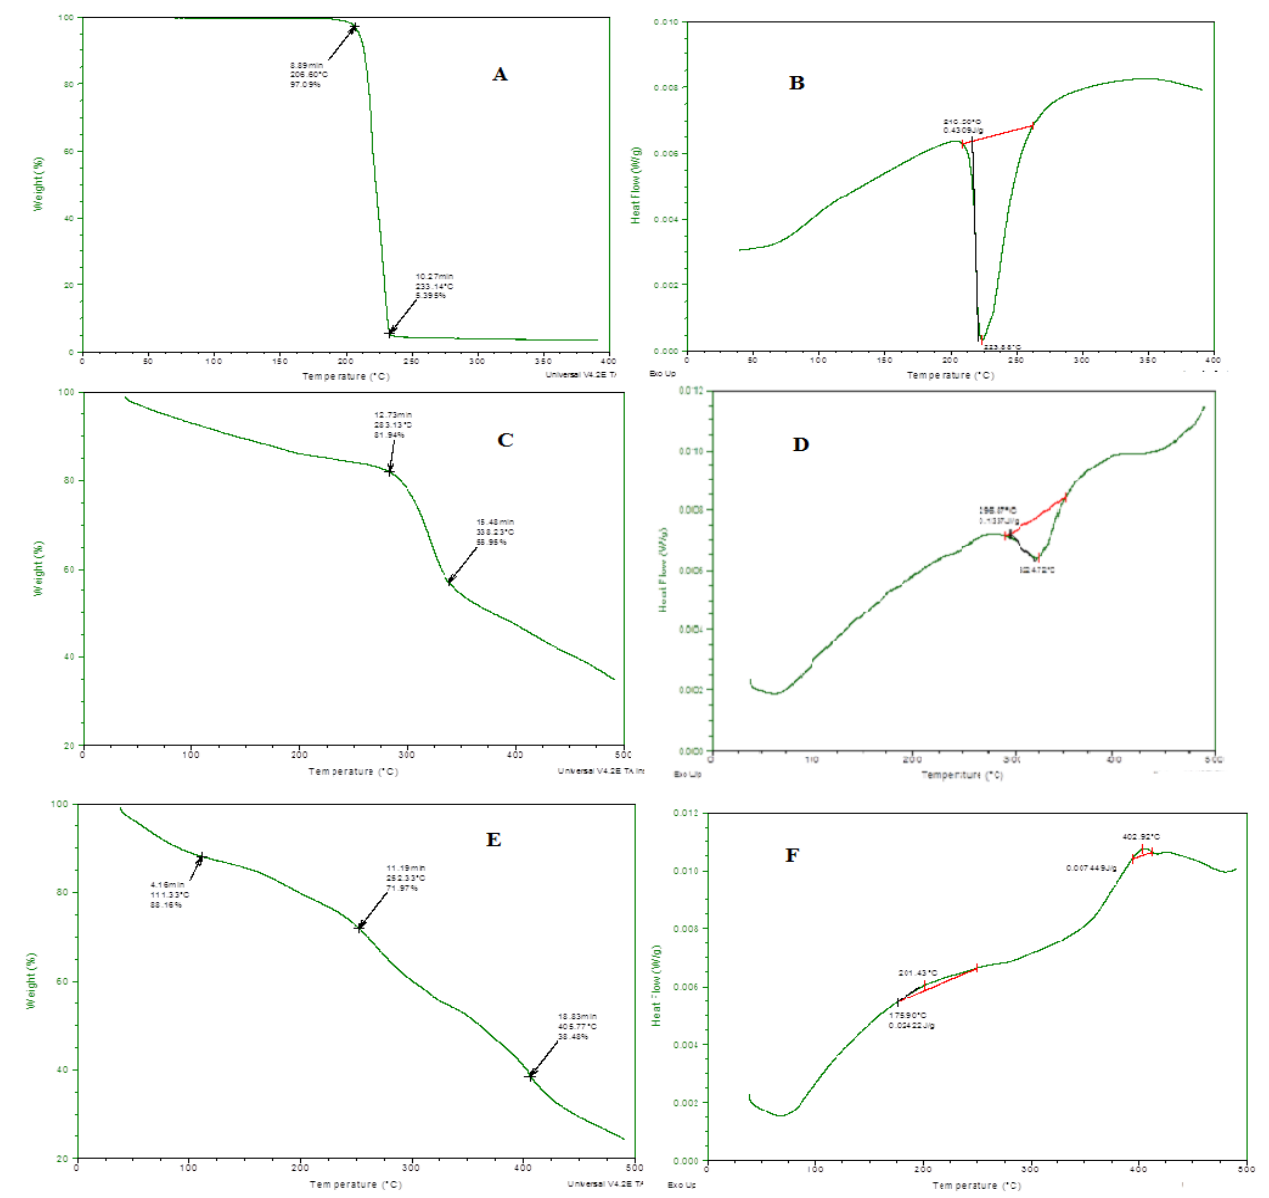
Figure 4. ( A ) TGA spectra of linalool, ( B ) DSC spectra of linalool, ( C ) TGA Spectra of eugenol, ( D ) DSC spectra of eugenol, ( E ) TGA spectra of ELE2, ( F ) DSC of ELE2.